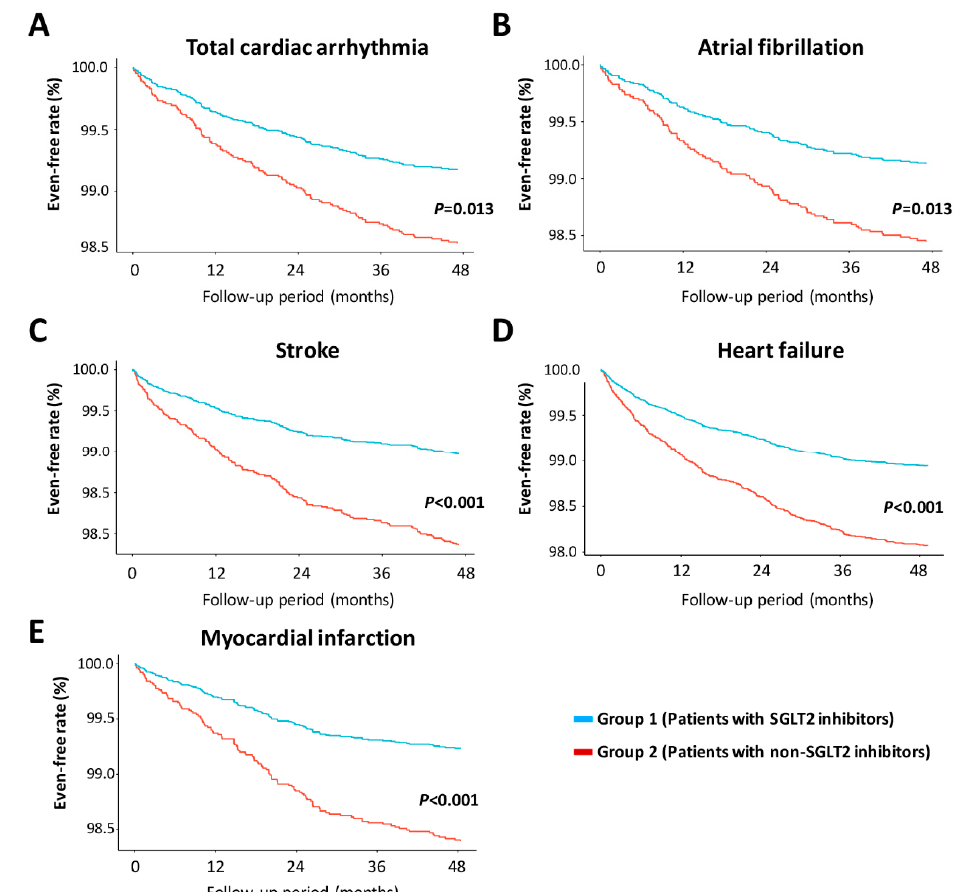
Figure 2. Kaplan–Meier plots demonstrated the time-to-event incidence of the primary and secondary study outcomes, including ( A ) total arrhythmia, ( B ) atrial fibrillation, ( C ) stroke, ( D ) heart failure, and ( E ) myocardial infarction. A significantly lower risk of cardiac arrhythmia and related cardiovascular disease was found in group 1 patients than in group 2 patients. All time-to-event incidence curves were generated after the multivariate Cox regression